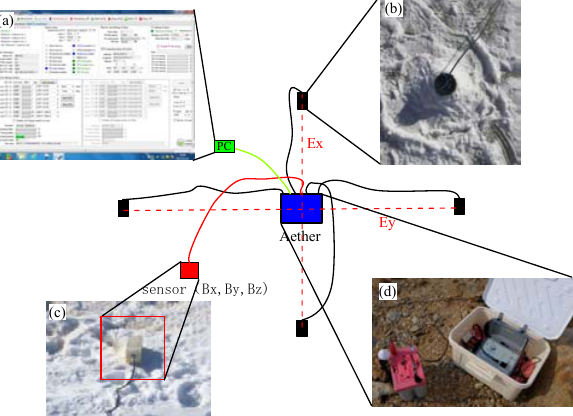
Figure 3. Aether multi-functional acquisition system. (a)control software; (b) non-polarizing electrode;(c) three- component fluxgate sensor; (d) Aether host.